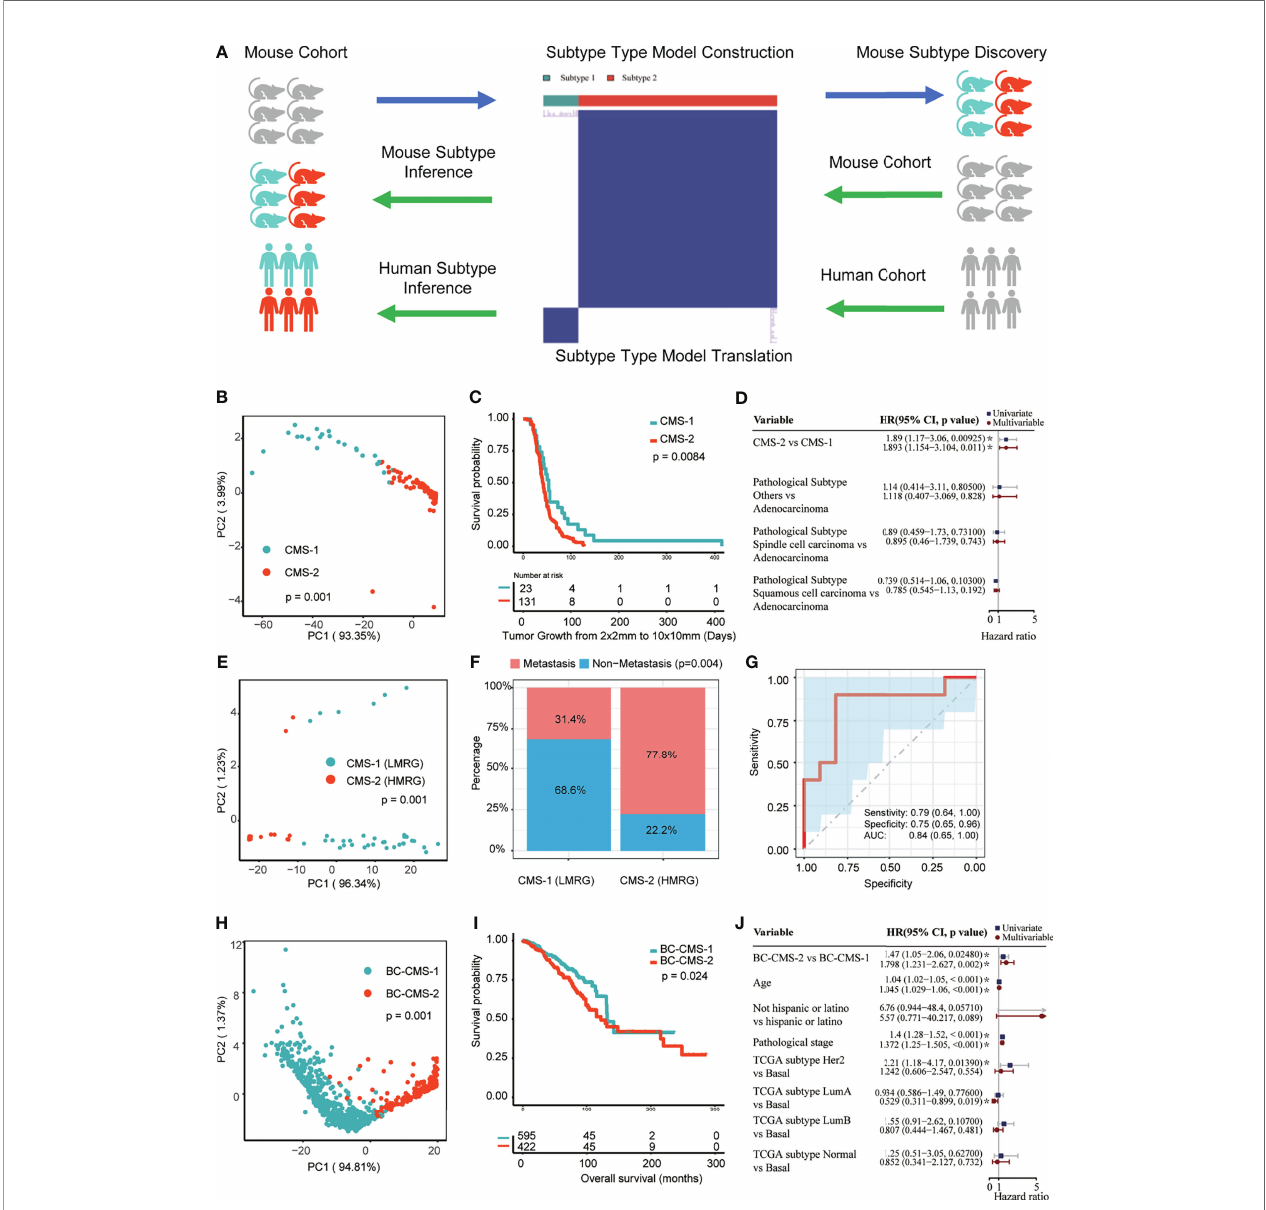
FIGURE 3 | Cellular morphometric subtypes (CMS) identi fi ed from one mouse mammary tumor model are informative in another mouse mammary tumor model and provides translational impact on human breast cancer. (A) Consensus clustering model for CMS identi fi cation and translation from one mouse mammary tumor model to another mouse mammary tumor model and human breast cancer. (B) CMS-speci fi c samples in the Trp53 -null cohort form distinct clusters in sample-level cellular morphometric context space. (C) CMS-speci fi c samples in the Trp53 -null cohort show signi fi cant difference in survival. (D) CMS in the Trp53 -null cohort is a signi fi cant and independent prognosis factor. (E) CMS-speci fi c samples in the MMTV-Erbb2 transgenic mouse mammary tumors cohort form distinct clusters in sample-level cellular morphometric context space. (F) CMS in MMTV-Erbb2 transgenic mouse mammary tumors cohort is signi fi cantly enriched with metastasis presence. (G) Cellular morphometric biomarkers predict metastasis presence in MMTV-Erbb2 transgenic mouse mammary tumors cohort with accuracy. (H) BC- CMS-speci fi c patients in the TCGA-BRCA cohort form distinct clusters in patient-level cellular morphometric context space. (I) BC-CMS-speci fi c patients in the TCGA-BRCA cohort show signi fi cant difference in OS. (J) BC-CMS in the TCGA-BRCA cohort is a signi fi cant and independent prognostic